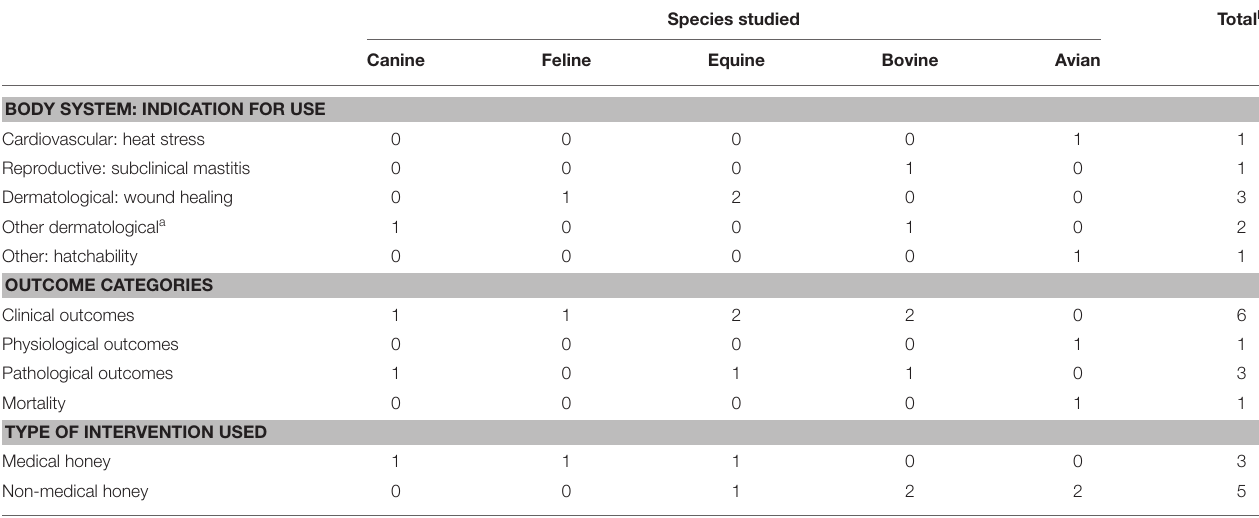
TABLE 3 | Summary of eight veterinary controlled trials included in a scoping review of the evidence for the medicinal use of honey in animals, characterised by species, indication for use, outcome category and type of honey used. Species studied Total b Canine Feline Equine Bovine Avian